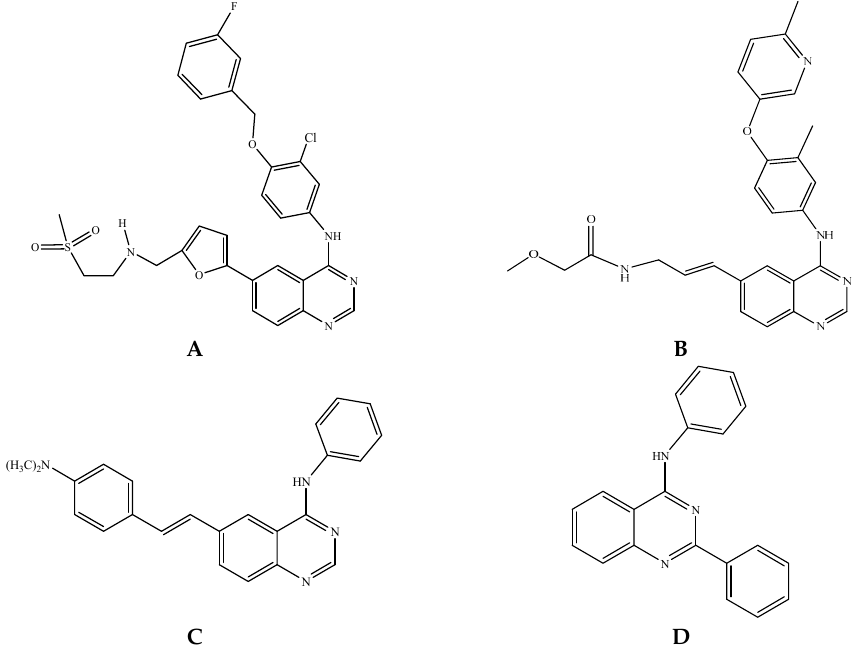
Figure 1. Structures of lapatinib ( A ); CP-724,714 ( B ); ( E )-6-(4-dimethylaminostyryl)- N -phenylquinazolin-4-amine ( C ) and 2-phenyl-4-(phenylamino)quinazoline ( D ).